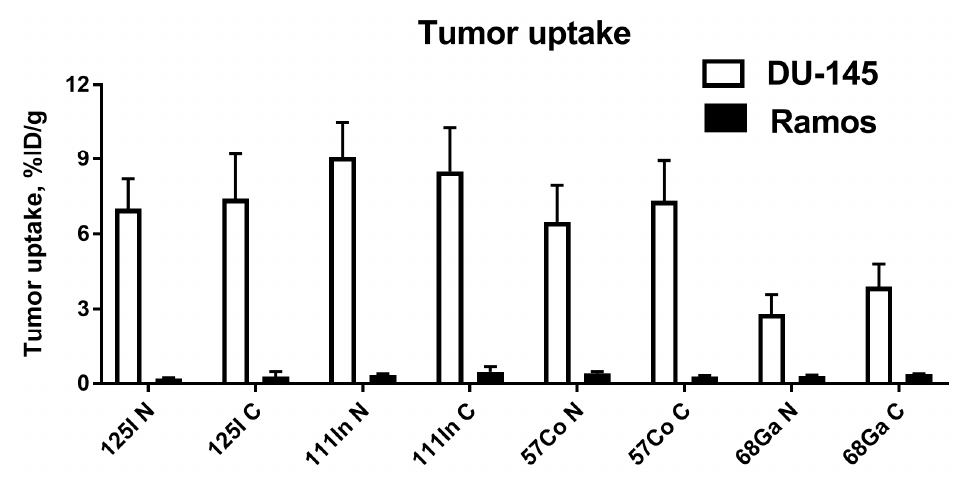
Figure 5. Tumor-targeting specificity of DARPin Ec1 variants labeled with [ 57 Co]Co, [ 68 Ga]Ga, [ 111 In]In and [ 125 I]I-HPEM at N - or C -terminus 3 h post injection (p.i.) in Balb/c nu/nu mice bearing EpCAM-expressing DU145 xenografts (n = 4–7) and EpCAM-negative Ramos xenografts (control, n = 4). Uptake is presented as % ID/g ± SD.